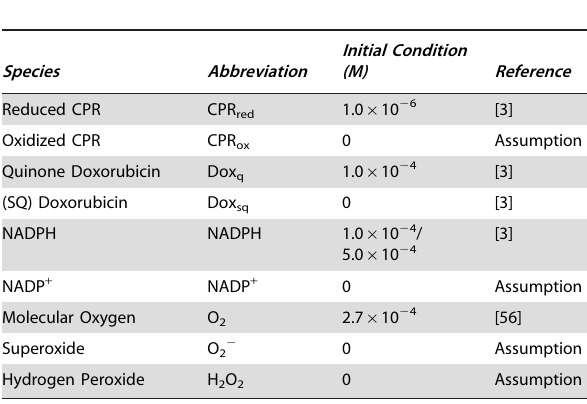
Table 1. Initial concentration values for the species utilized in the in vitro Dox